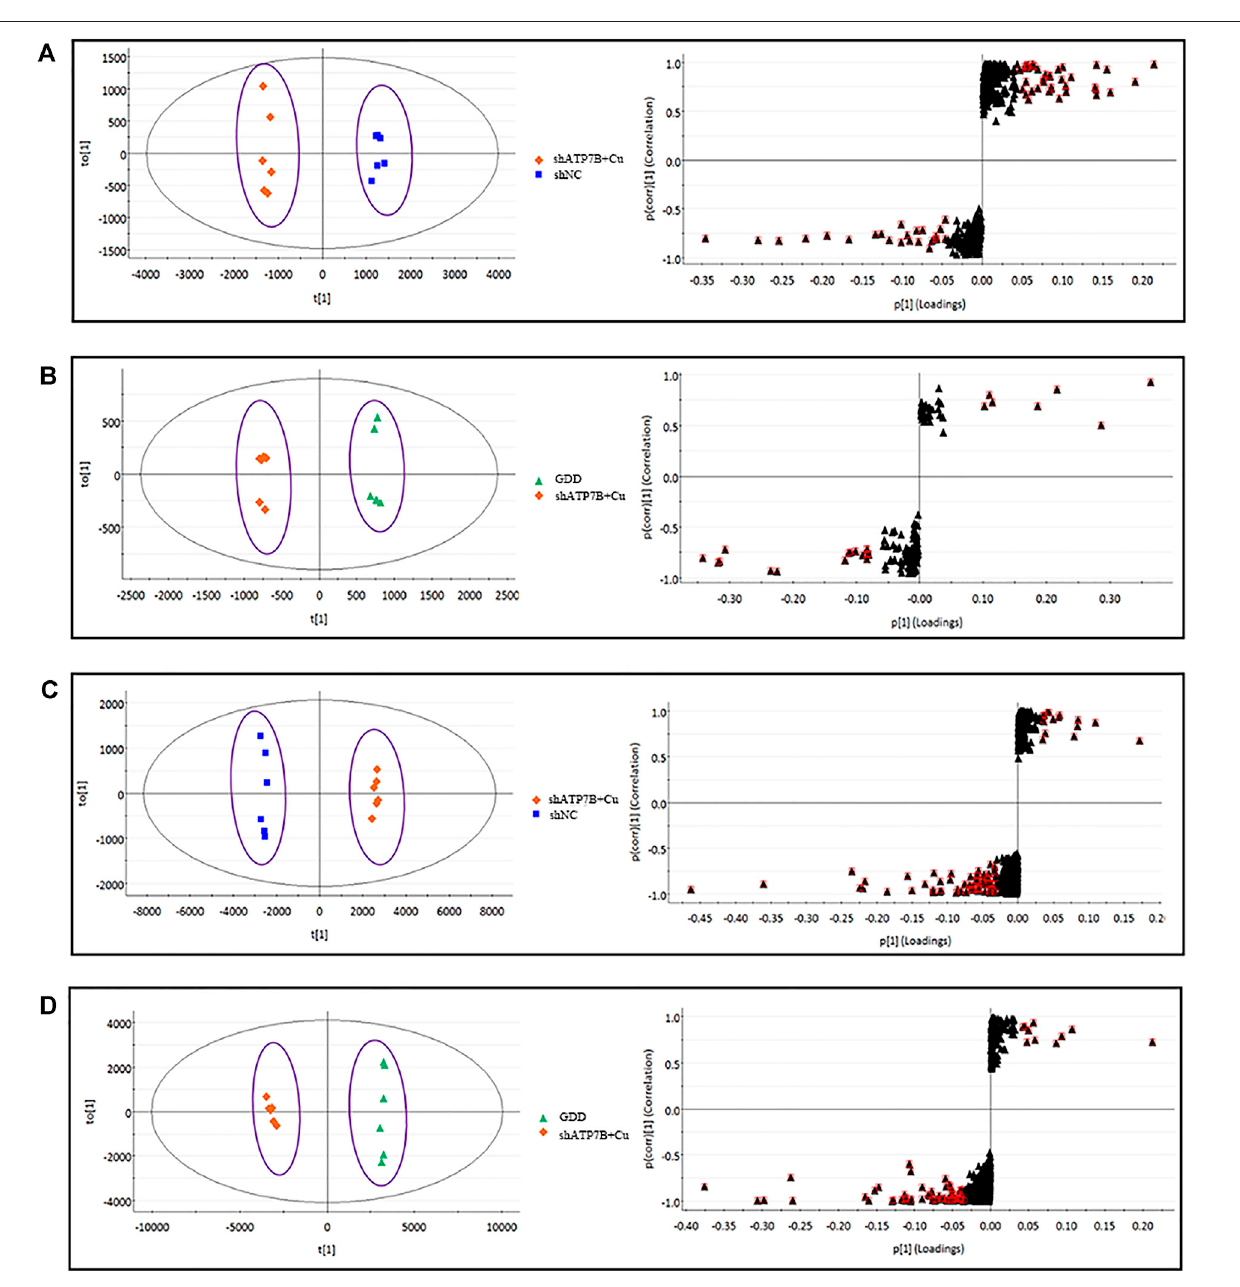
FIGURE7| (shNCgroup,shATP7B+Cugroup,andGDDgroup)OPLS-DAscoreanditscorrespondingS-plotfordifferentialanalysisbetweendifferentgroupsof cellsamplesinRPLC-Q-TOF/MSnegativeandpositiveESImode.[ (A) .NEG-R 2 Y=99%,Q 2 =97%; (B) .NEG-R 2 Y=99%,Q 2 =99%; (C) .POS-R 2 Y=1,Q 2 =99%; (D) . POS- R 2 Y = 1, Q 2 =